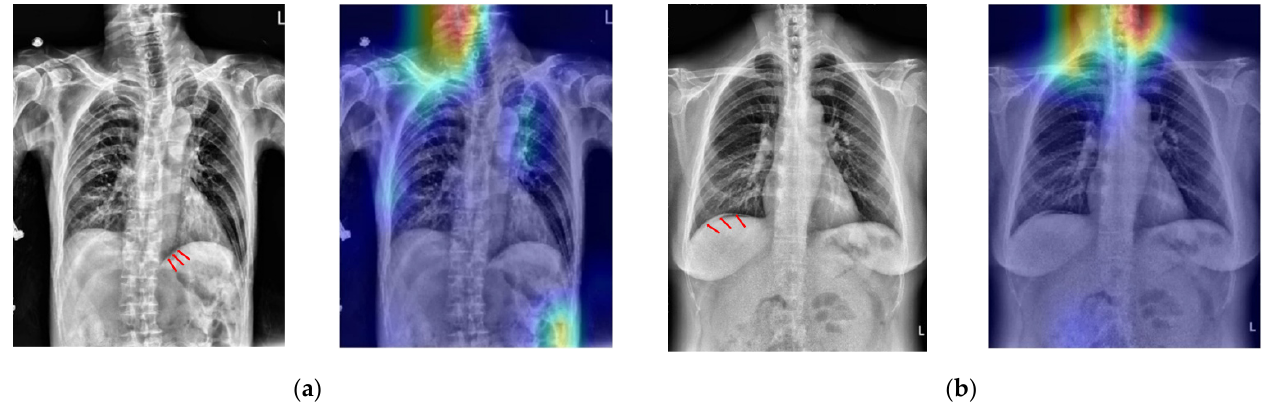
Figure 9. The raw X-ray images and the corresponding heatmaps of two FN cases ( a ) and ( b ). The deep model could not detect the small signs of pneumoperitoneum pointed out by the red arrows.